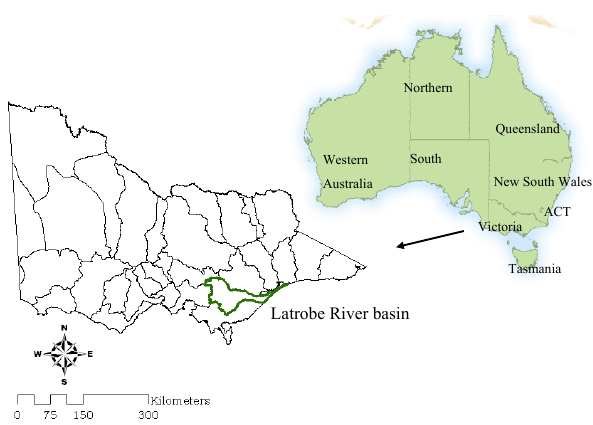
Fig. 16. Latrobe River Basin location in Victoria, Australia.